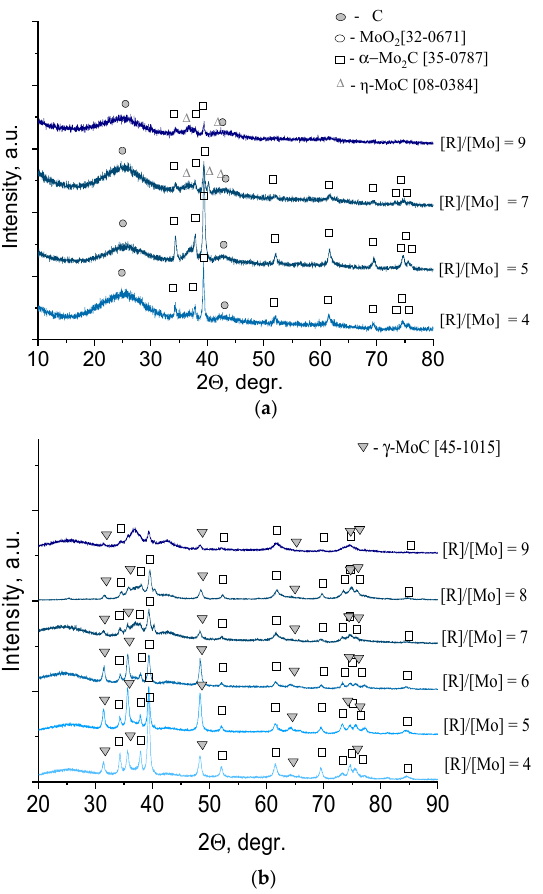
Figure 5. XRD pattern of molybdenum blue xerogels synthesized using ( a ) glucose and ( b ) hydro- quinone with different R/Mo molar ratios calcined at 900 °C in an inert N 2 atmosphere. Samples with a low reducing agent content (glucose, R/Mo = 4–5) were characterized by the presence of one phase of molybdenum carbide, β -Mo 2 C (35-0787). The sample with